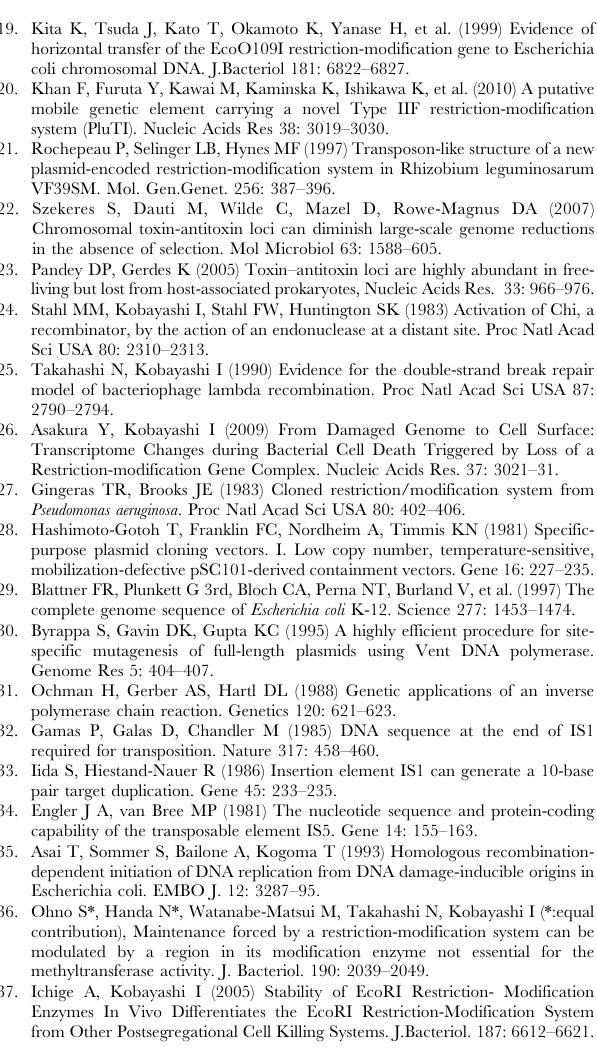
Figure S6 Pulsed-field gel electrophoresis. Cell cultures at O.D.0.6 each of MG1655(no plasmid), MG1655(with pSO429 (R + )), and MG1655(with pSO431(R 2 )) after 0, 6, 24 hours of